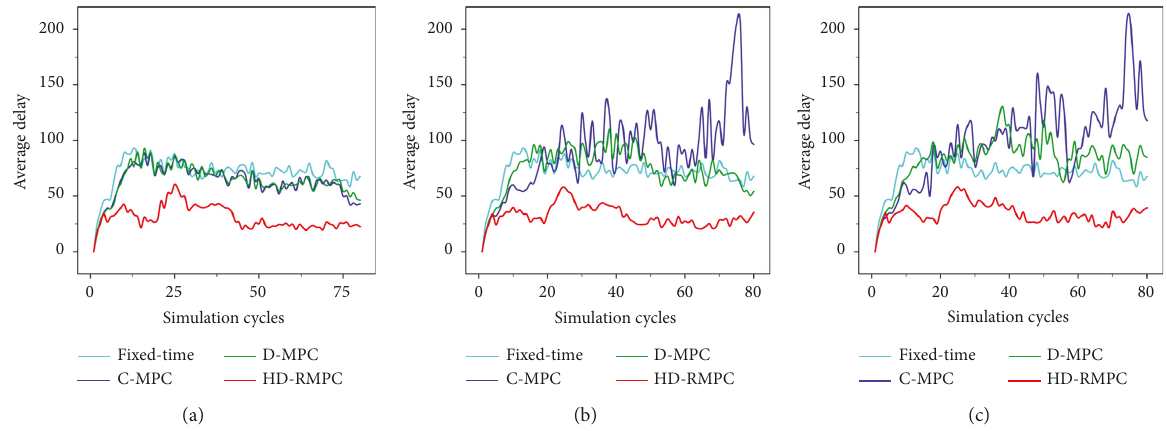
Figure 11: Average vehicle delay variation in simulation using baselines and the proposed HD-RMPC. (a) N